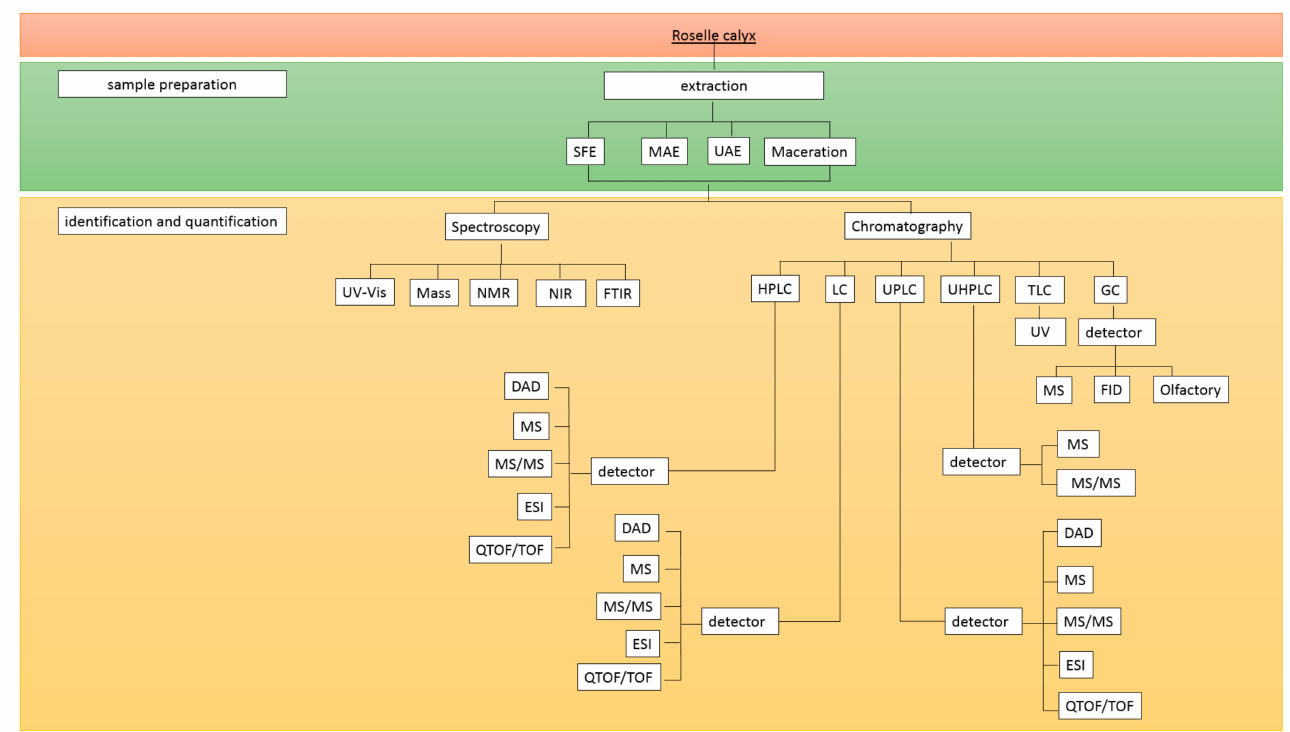
Figure 2. Diagram of the analytical methods to determine the phenolic compounds in roselle. Abbreviations: SFE: Supercritical Fluid Extraction, MAE: Microwave-Assisted Extraction, UAE: Ul-tra-sound-Assisted-Extraction, UV-Vis: ultra-violet-visible, NMR: nuclear magnetic resonance, NIR: near-infrared spec-troscopy, FTIR: Fourier Transform Infrared Spectrometer, HPLC: high-performance liquid chromatography, LC: liquid chromatography, UPLC: ultra-performance liquid chromatography, UHPLC: ultrahigh-performance liquid chromatog-raphy, TLC: thin-layer chromatography, GC: gas chromatography, DAD: diode array detector, PDA: photodiode array detector, MS: mass spectrophotometry, ESI: electrospray ionization, TOF/QTOF: quadrupole time-of-flight, FID: flame ionization